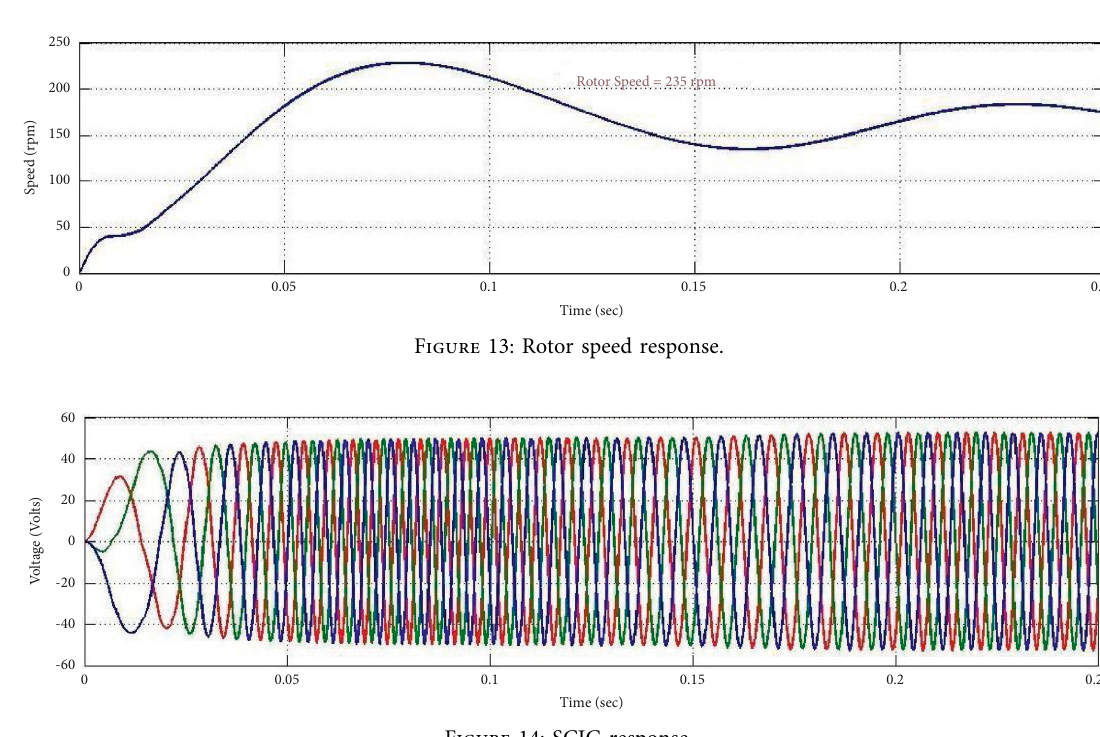
Figure 14: SCIG response.